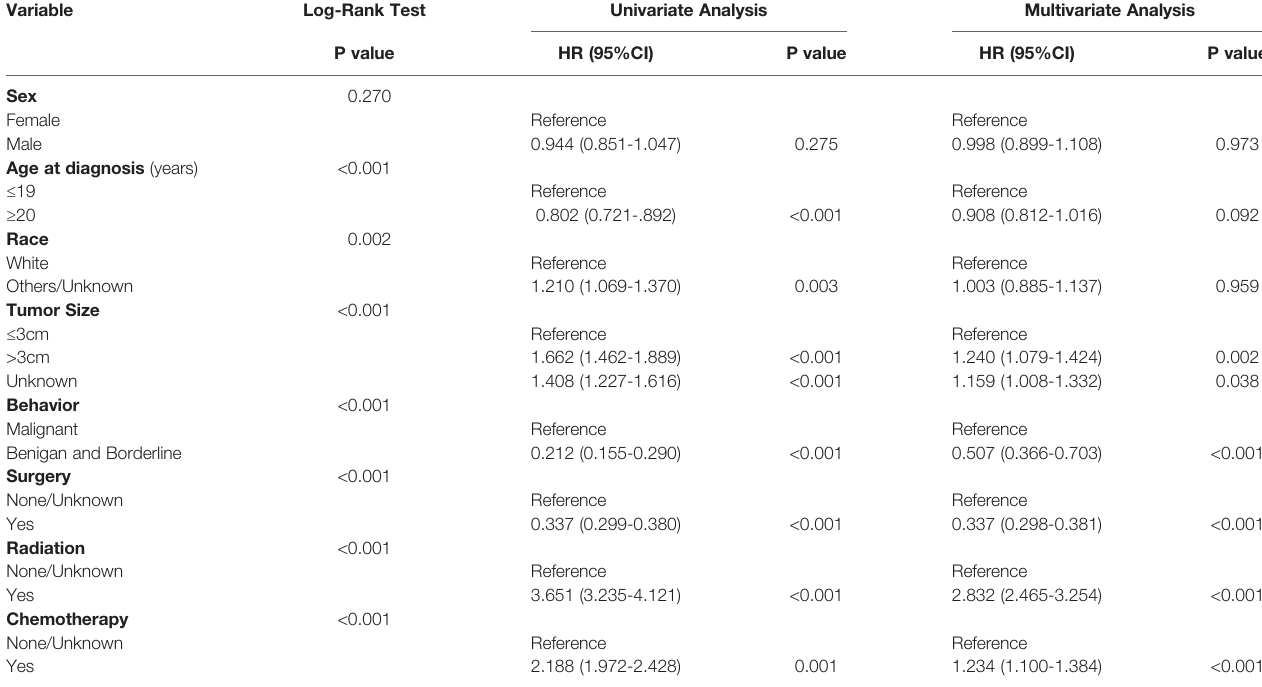
TABLE 2 | Results of the log-rank test and univariate and multivariate Cox regression analysis.